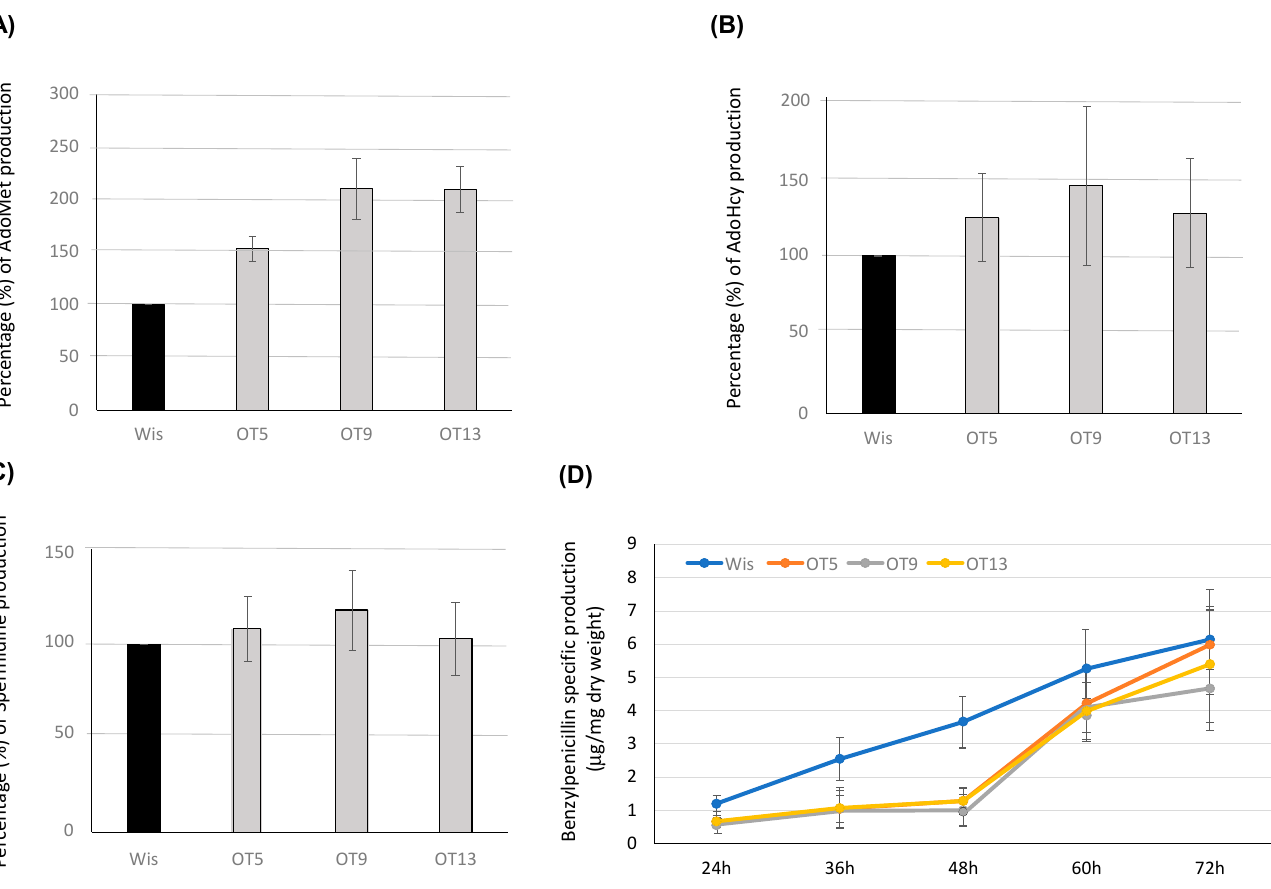
Figure 7. Production of AdoMet, AdoHcy, spermidine and benzylpenicillin in overexpression transformants. Percentage (%) of intracellular levels of ( A ) AdoMet, ( B ) AdoHcy and ( C ) Spermidine in the overexpression transformants OT5, OT9 and OT13 regarding values provided by the Wisconsin 54-1255 strain (Wis), which were set to 100%. ( D ) Benzylpenicillin specific production ( μ g/mg dry weight) of the control strain Wisconsin 54-1255 (Wis) and overexpression transformants OT5, OT9 and OT13 grown in defined medium. Results correspond to the mean ± SD from three different experiments carried out in